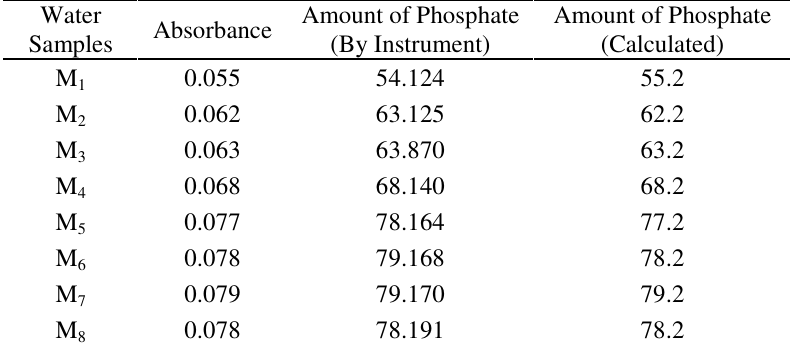
Table 6. Absorbance and concentration of phosphate (by Instrument and Calculation) of water samples of Mosam